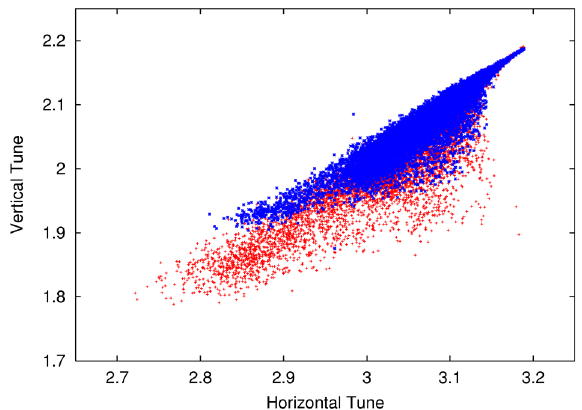
FIG. 28. (Color) Tune footprints of the beam in the real PSR lattice (blue points), and the symmetric, PSR-like lattice (red points). The bare tune for both cases is (cid:3) (cid:4)